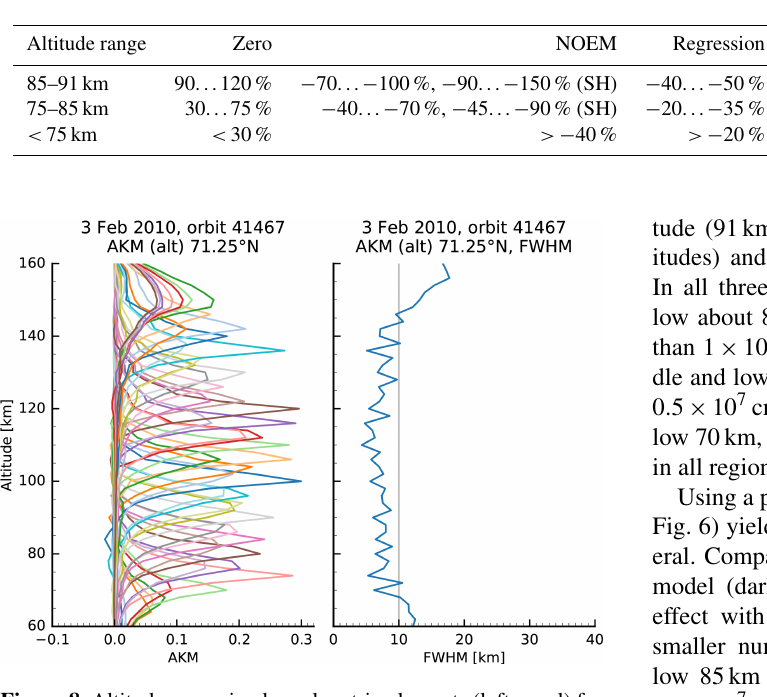
Figure 7. Median of the NO number densities (left) and the relative differences (right) using the scaled a priori values compared to the full SCIAMACHY MLT limb scan number densities. Table 2. Differences of the NO number densities using the different a priori choice compared to the full MLT limb scan retrieved values. NH and SH indicate exceptions at high northern and high southern latitudes.